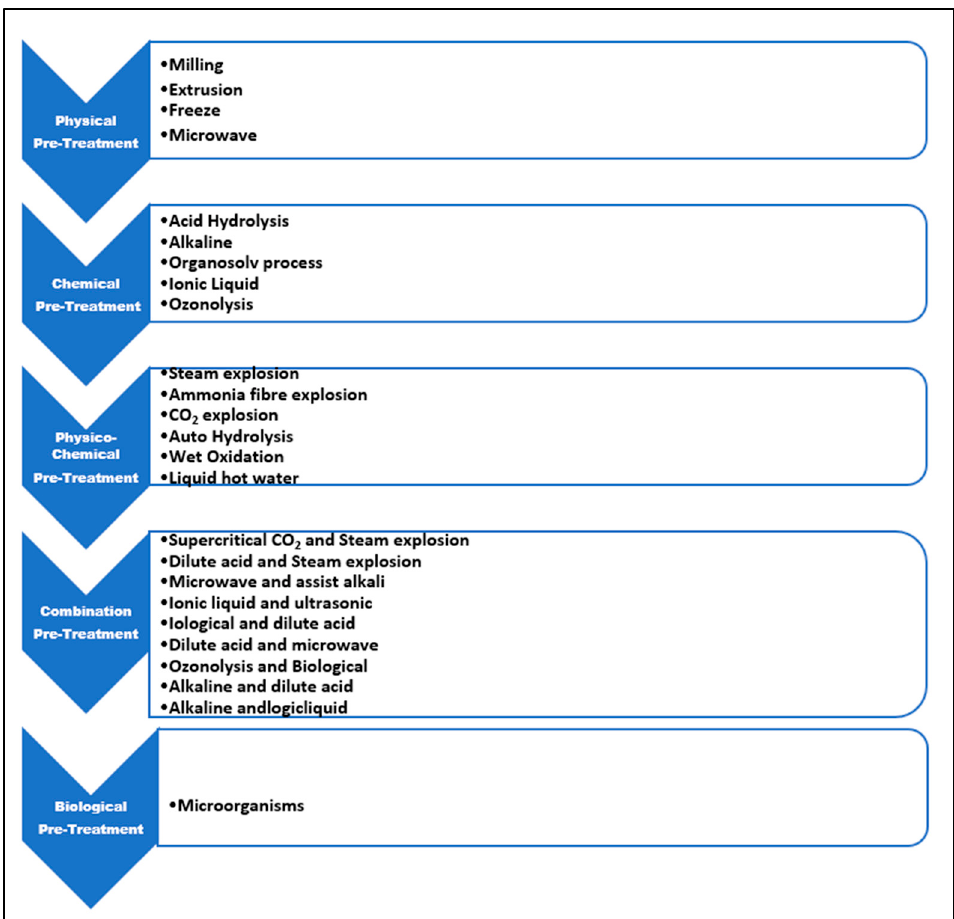
Figure 4. Pretreatment types used for lignocellulosic fermentation.